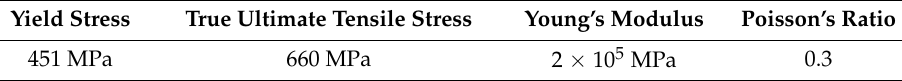
Figure 1. True stress versus true strain for API X60 pipe. Table 1. Material properties for API X60 pipe.